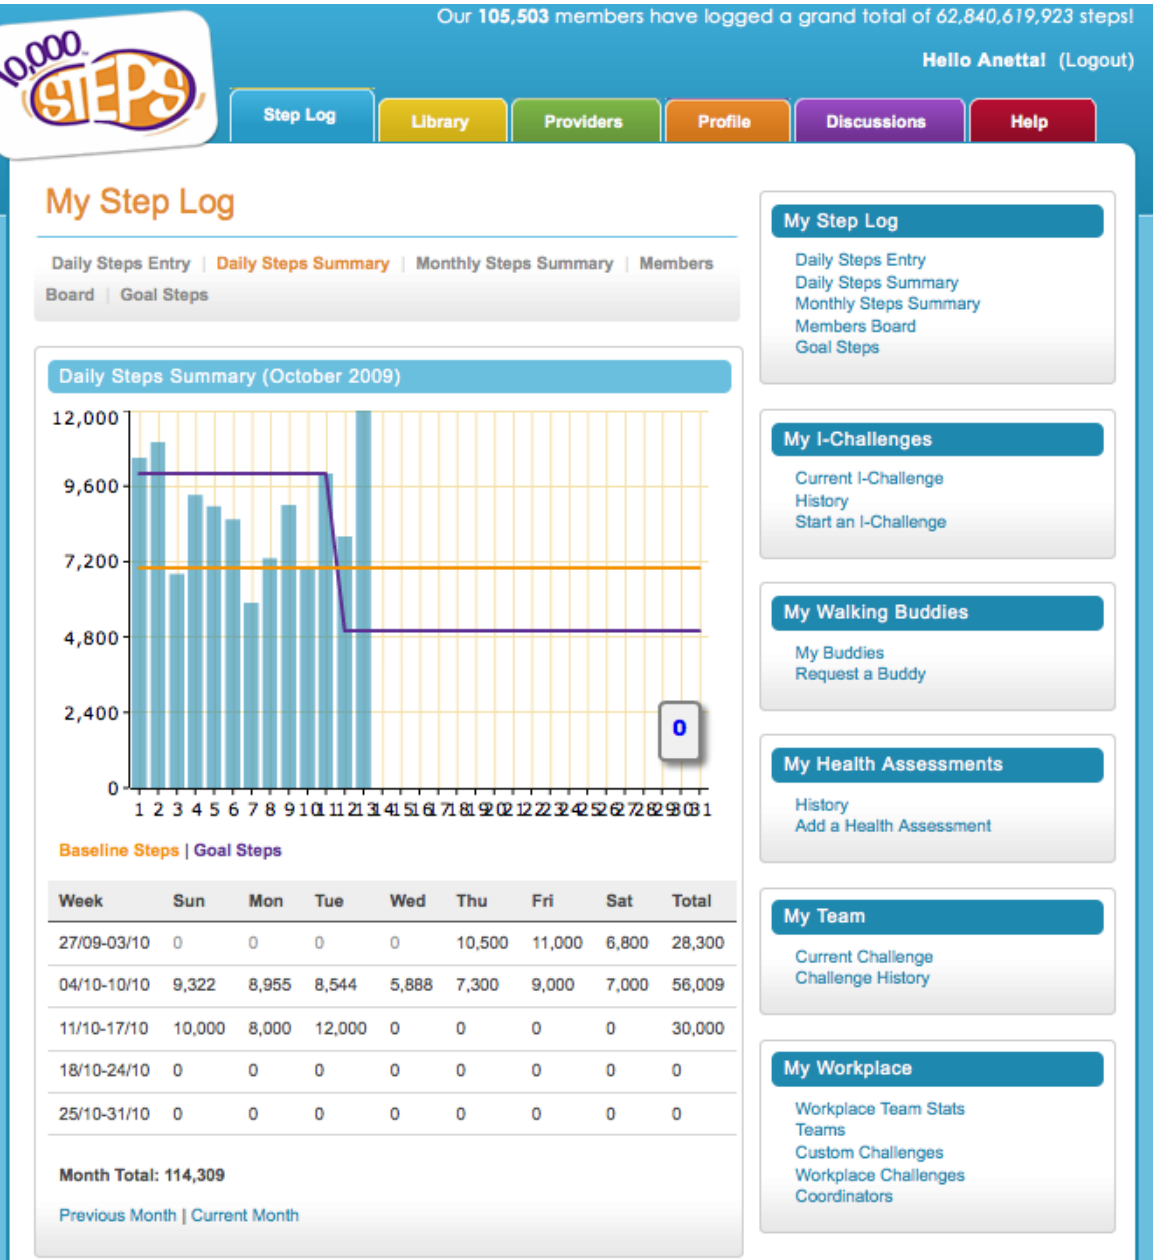
Figure 1. Screenshot of the online Step Log